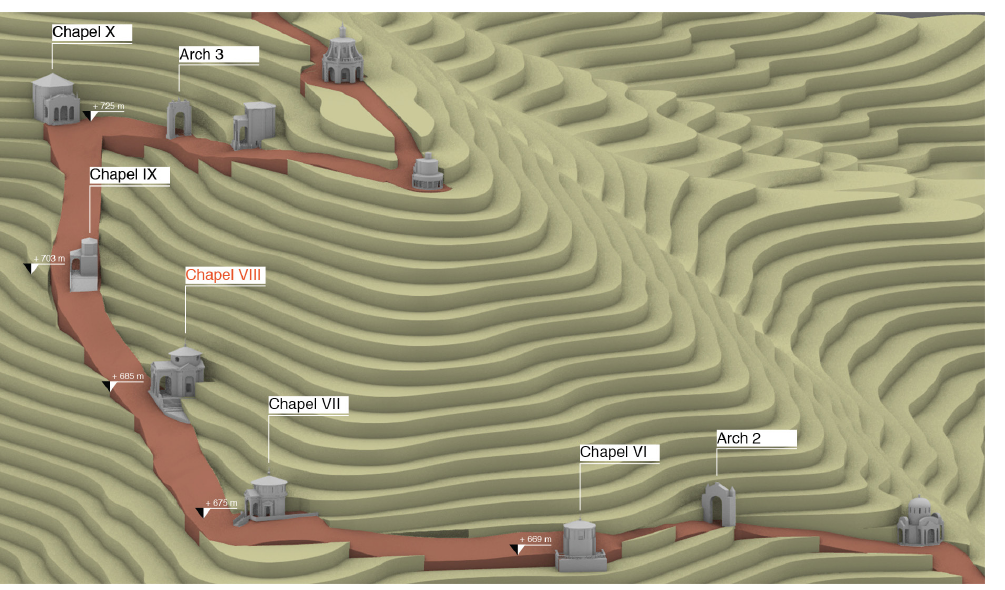
Fig. 4 Digital model of the